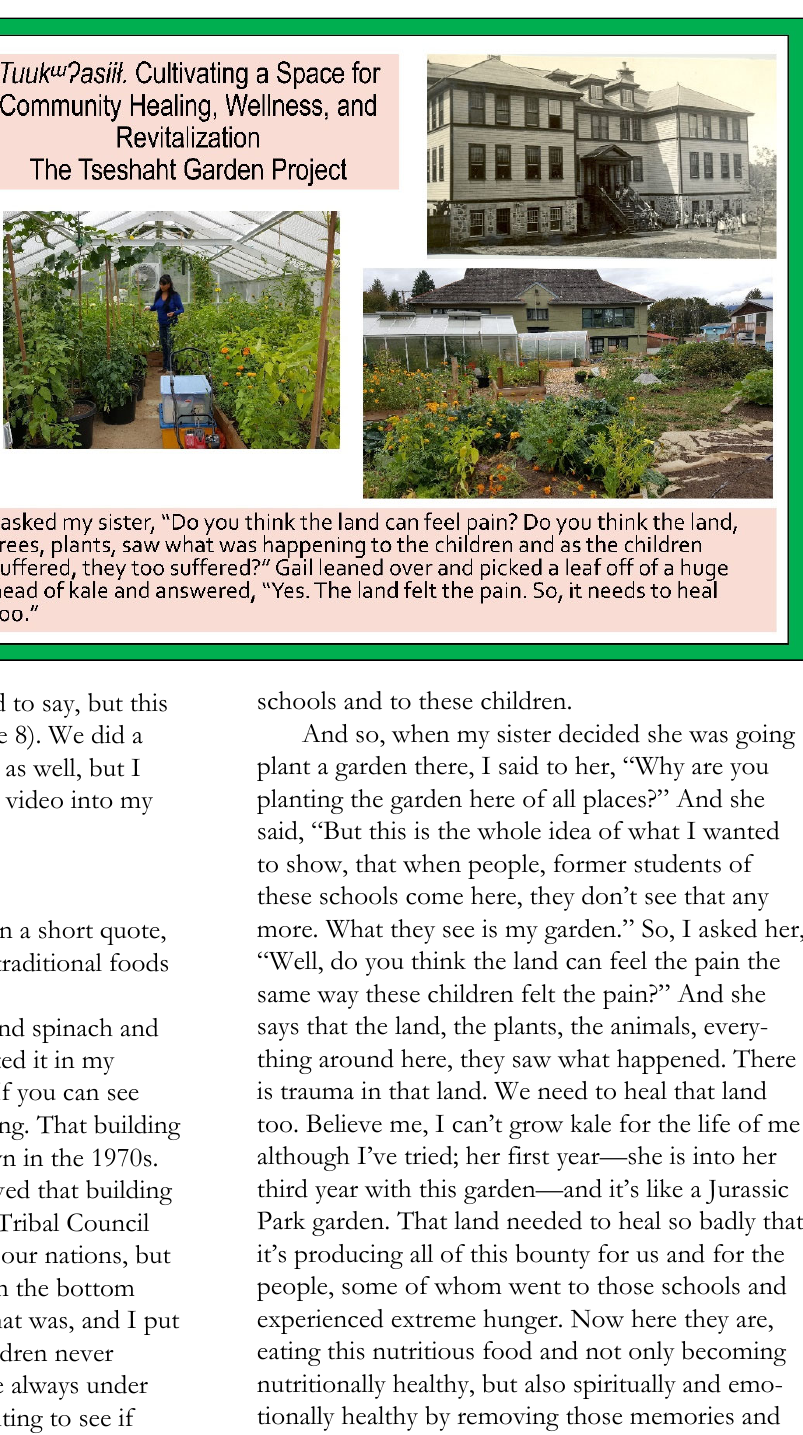
Figure 9. The Tseshaht Garden